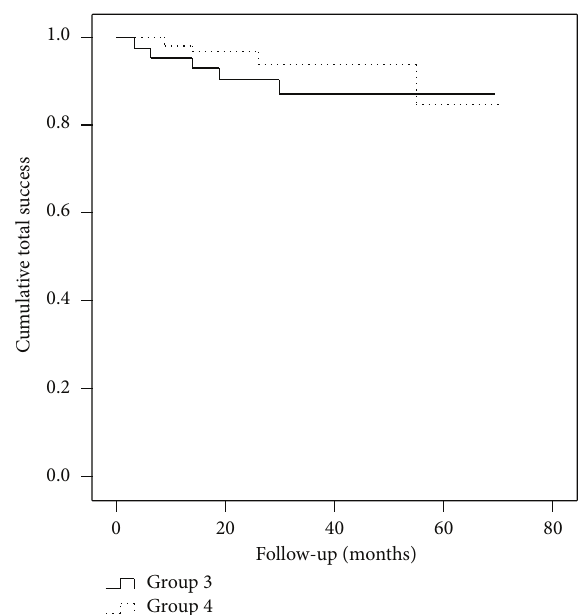
Figure3:Life-tablecurvesofcumulativesuccessratesingroup3(no previous cataract surgery, 𝑛 = 45 ) and in group 4 (previous cataract surgery, 𝑛 = 61 ). The difference calculated for the entire follow-up period was not statistically significant (log-rank 𝑃 = 0.451